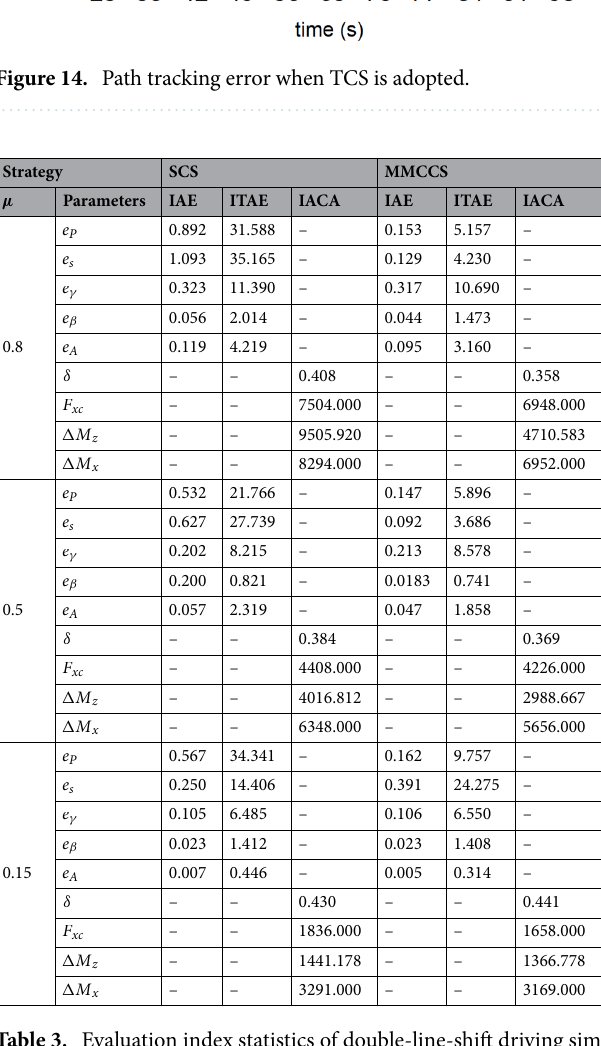
Table 3. Evaluation index statistics of double-line-shift driving